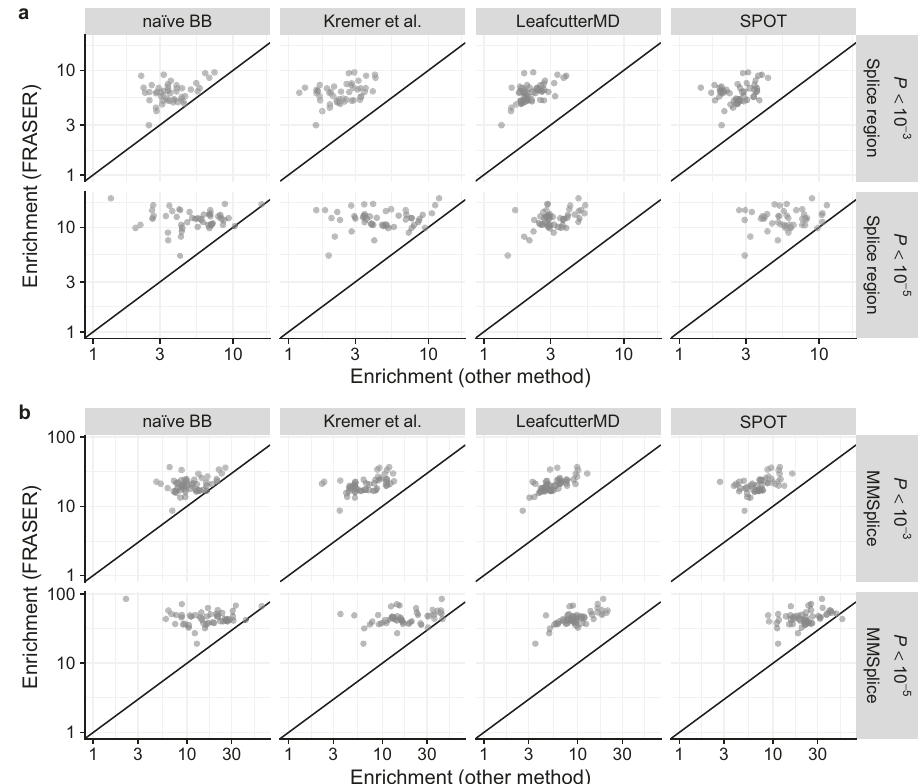
Fig. 5 Enrichment for rare variants predicted to affect splicing. a Enrichment using FRASER ( y -axis) against enrichment ( x -axis) using different aberrant splicing detection methods (columns) for rare variants located in a splice region. The enrichment is calculated for different nominal P value cutoffs (rows). The applied methods are a naïve beta-binomial regression, the LeafCutter adaptation of Kremer et al. 17 , LeafCutterMD 20 , and SPOT 21 . Each dot represents a GTEx tissue ( n = 48). b Same as a but the enrichment is computed for rare variants predicted to affect splicing by MMSplice 10 . BB